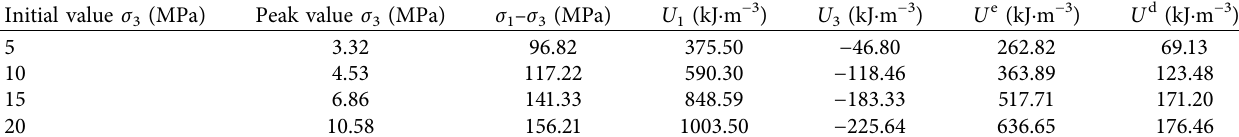
Table 2: Strain energy at peak strength points or the rock specimen under unloading confining pressure. Initial value σ 3 (MPa)